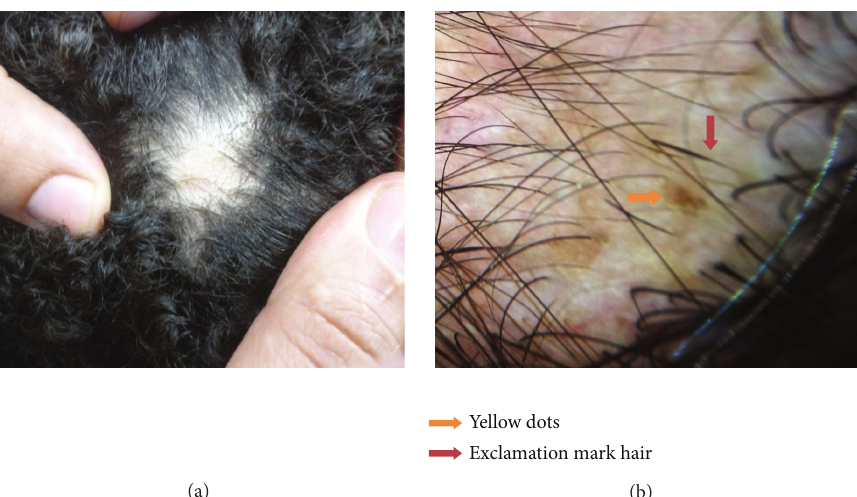
Figure2:Alopeciaareata(a)macroscopicview,(b)trichoscopicviewat40xmagnification,showsyellowdots(orangearrow)andexclamation mark hair (pink arrow).